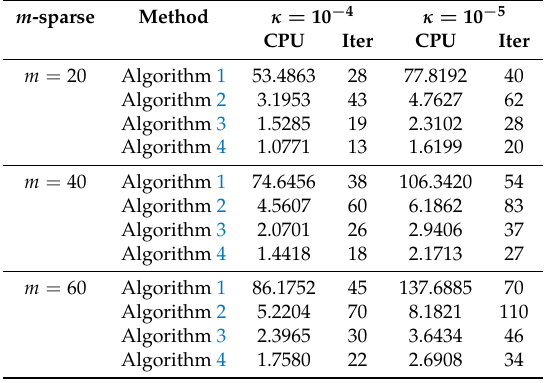
Table 2. Numerical results ( M = 2048 and N =